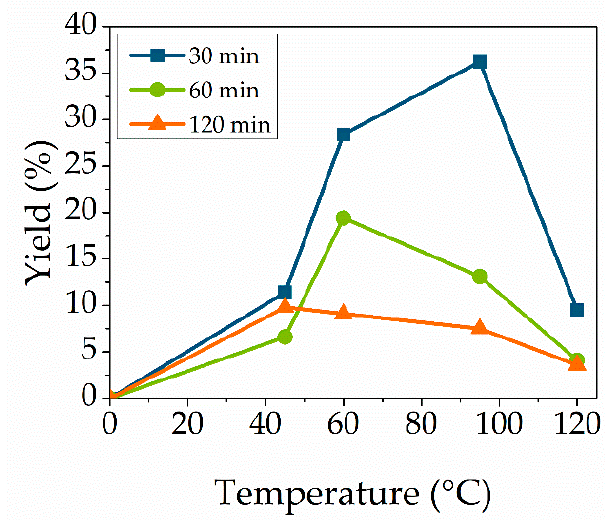
Figure 5. Effect of reaction time. Reaction conditions: cytidine (100 mg, 0.414 mmol), Novozym 435 (12.7 wt%), 1:35 molar ratio vinyl methacrylate at reaction times of 30 min (blue), 60 min (green) or 120 min (orange). Lines are included as a guide to the eye.